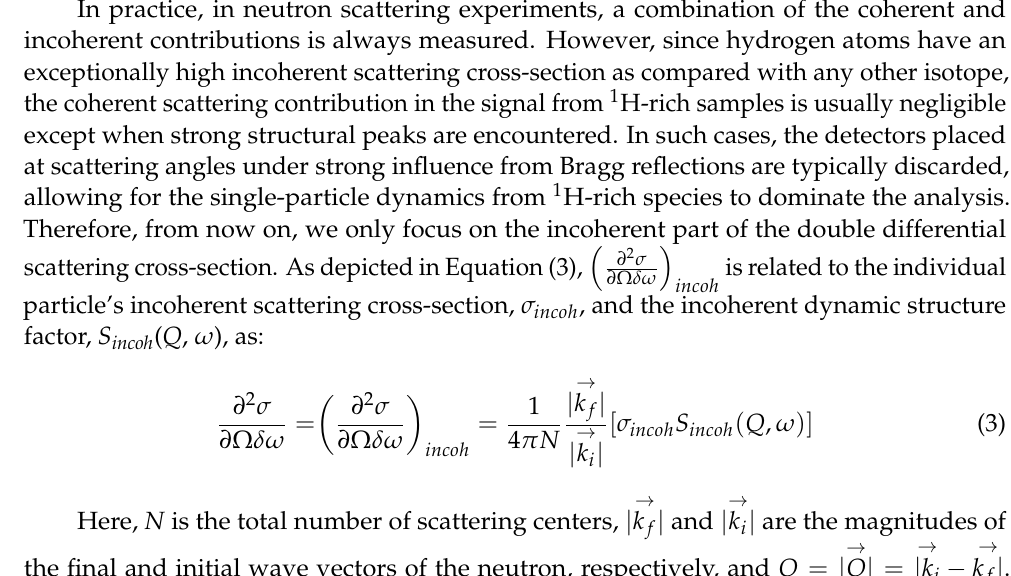
Figure 2. Graphical representation of a single particle scattering. The incoming neutron waves are scattered by a particle i at different times, 0 and t, and positions, 𝑟 𝑖 (0)⃗⃗⃗⃗⃗⃗⃗⃗⃗⃗ and 𝑟 𝑖 (𝑡)⃗⃗⃗⃗⃗⃗⃗⃗⃗. The scattered waves interfere with each other before detection. The scattering triangle is also represented in the figure.